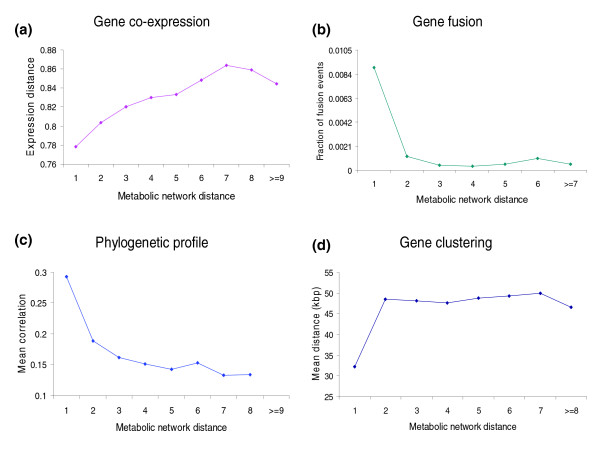
Context-based associations versus the metabolic network distance for the yeast metabolic network. (a) mRNA expression distance. The expression distance is calculated as 1-|correlation|, where correlation is the Spearman's rank correlation between genes' mRNA expression. Close neighbors in the metabolic network have similar expression profiles. (b) Gene fusion events (Rosetta Stone). The fraction of proteins involved in gene fusion events. The adjacent genes in the network are much more likely to form a Rosetta Stone protein. (c) Phylogenetic profiles. Pearson's correlations between phylogenetic profiles for genes close in the network are more likely to be similar. (d) Chromosomal distance between genes. The mean physical distances (in kilobase pairs (kbp)) between ORFs are shown. The adjacent genes in the network are significantly closer to each other on yeast chromosomes.